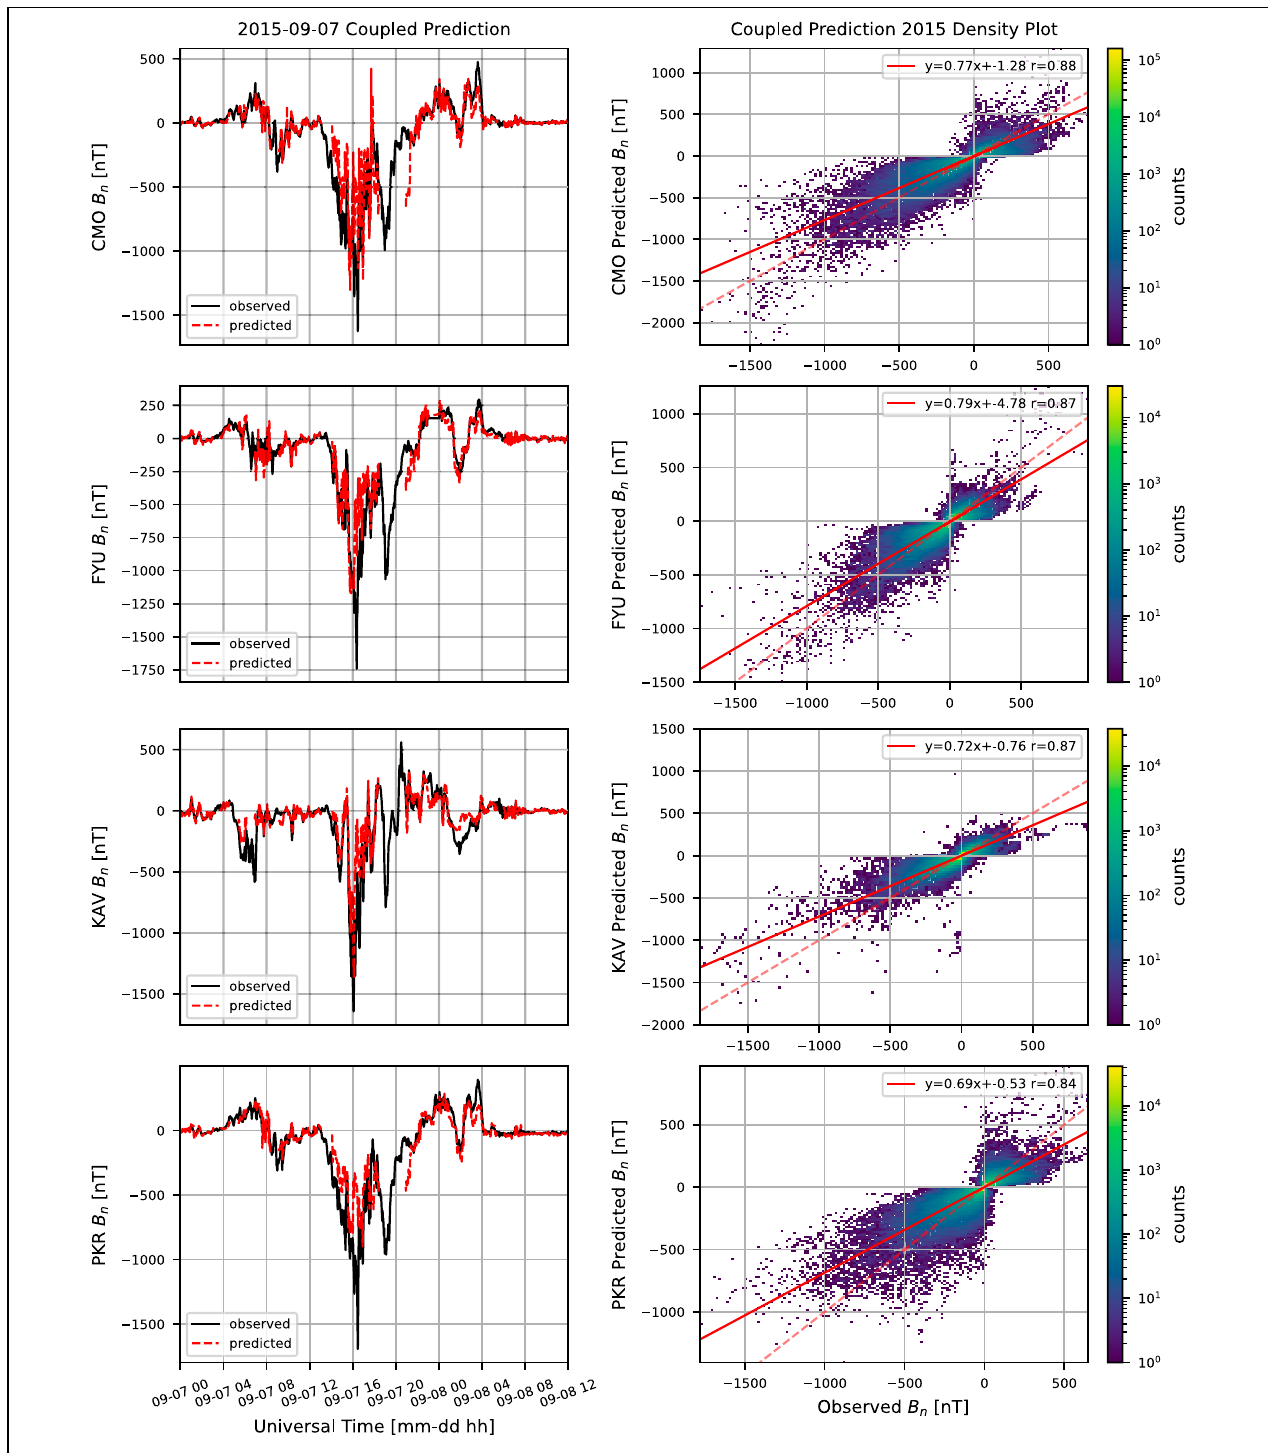
FIGURE 6 | Coupled model storm predictions. In the left column the coupled models ability to predict B N for the 07-Sep-2015 storm is plotted against the observed data for each station. In the right column the density plot for each station is shown for the 2015 dataset. The predictions of the coupled models provide better Pearson correlation coefficients than the original LSTM | B N | while following the storm time fluctuations, indicating the Polarity model is providing the necessary information to the | B N |